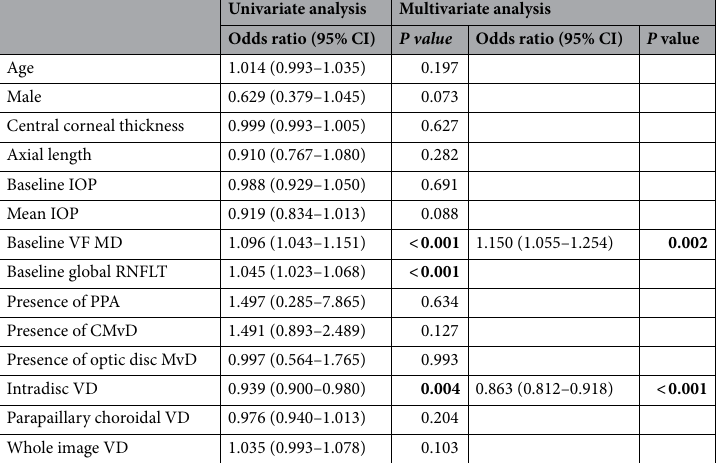
Table 3. Univariate and multivariate logistic regression analyses for clinical factors associated with occurrence of optic disc hemorrhage during follow-up in eyes with primary open-angle glaucoma. CI confidence interval, IOP intraocular pressure, VF visual field, MD mean deviation, RNFLT retinal nerve fiber layer thickness, PPA parapapillary atrophy, CMvD choroidal microvascular dropout, MvD microvascular dropout, VD vessel density. Significant values are in